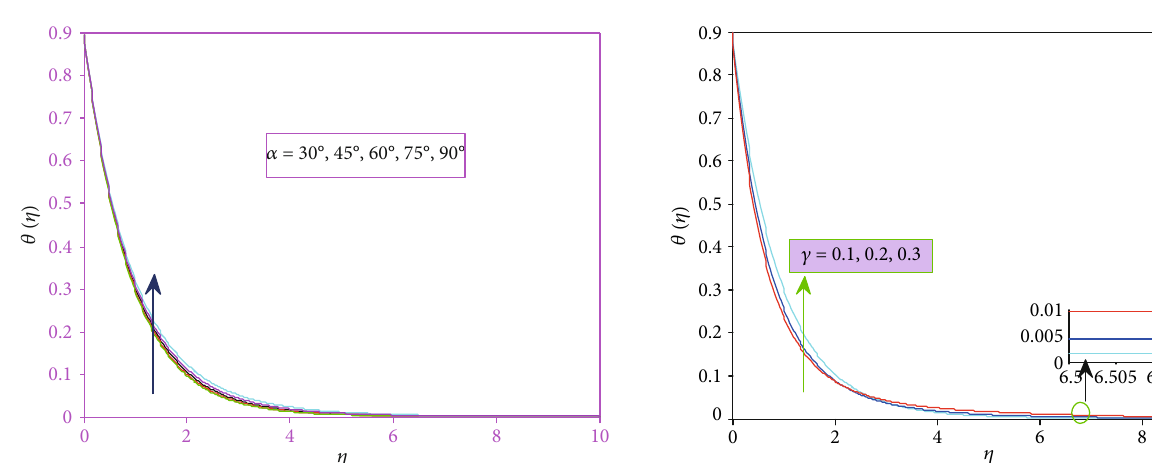
Figure 12: Temperature distribution for di ff erent inclinations.